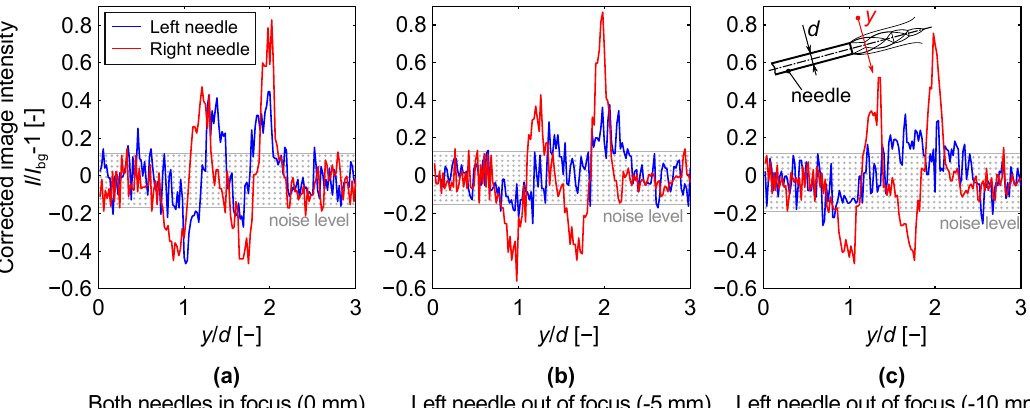
Figure 5. Corrected image intensity in under-expanded jets from left and right needles for three planes of focus. ( a ) 0 mm; ( b ) − 5 mm; and ( c ) − 10 mm. The intensity profiles correspond to the photographs shown in Figure